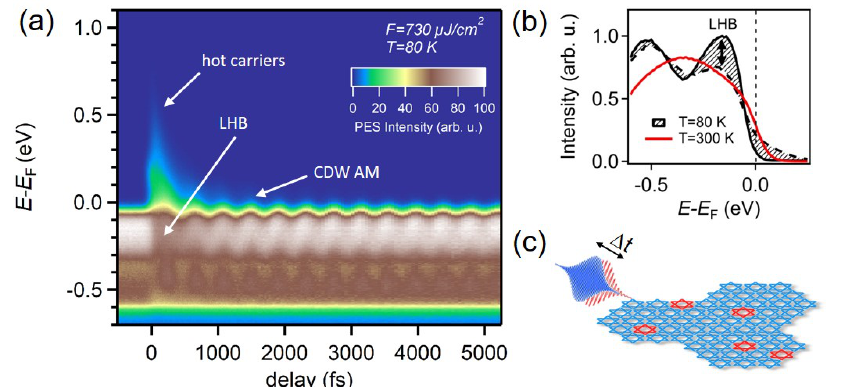
Figure 2. ( a ) False-color representation of data obtained for an incident pump fluence F = 730 µ J cm − 2 at sample base temperature T = 80 K. An instantaneous collapse and subsequent recovery of the LHB signature is observed along with the generation of a hot carrier continuum and oscillations of the spectral weight due to the coherent excitation of the CDW amplitude mode; ( b ) Photoemission spectra of the room-temperature and insulating phase (red and black solid lines, respectively). The shaded area indicates the photo-induced change of the low-temperature spectrum upon strong optical pumping ( F = 1700 µ J/cm 2 ); ( c ) Illustration of the laser-excited charge ordered state, as concluded from the femtosecond photoemission studies. The sample is excited by a femtosecond IR pulse to partly turn single polaron clusters (blue stars) to become metallic (red stars). Subsequent probing through photoemission by the UV pulse maps the coexistence of both phases at delay ∆ t